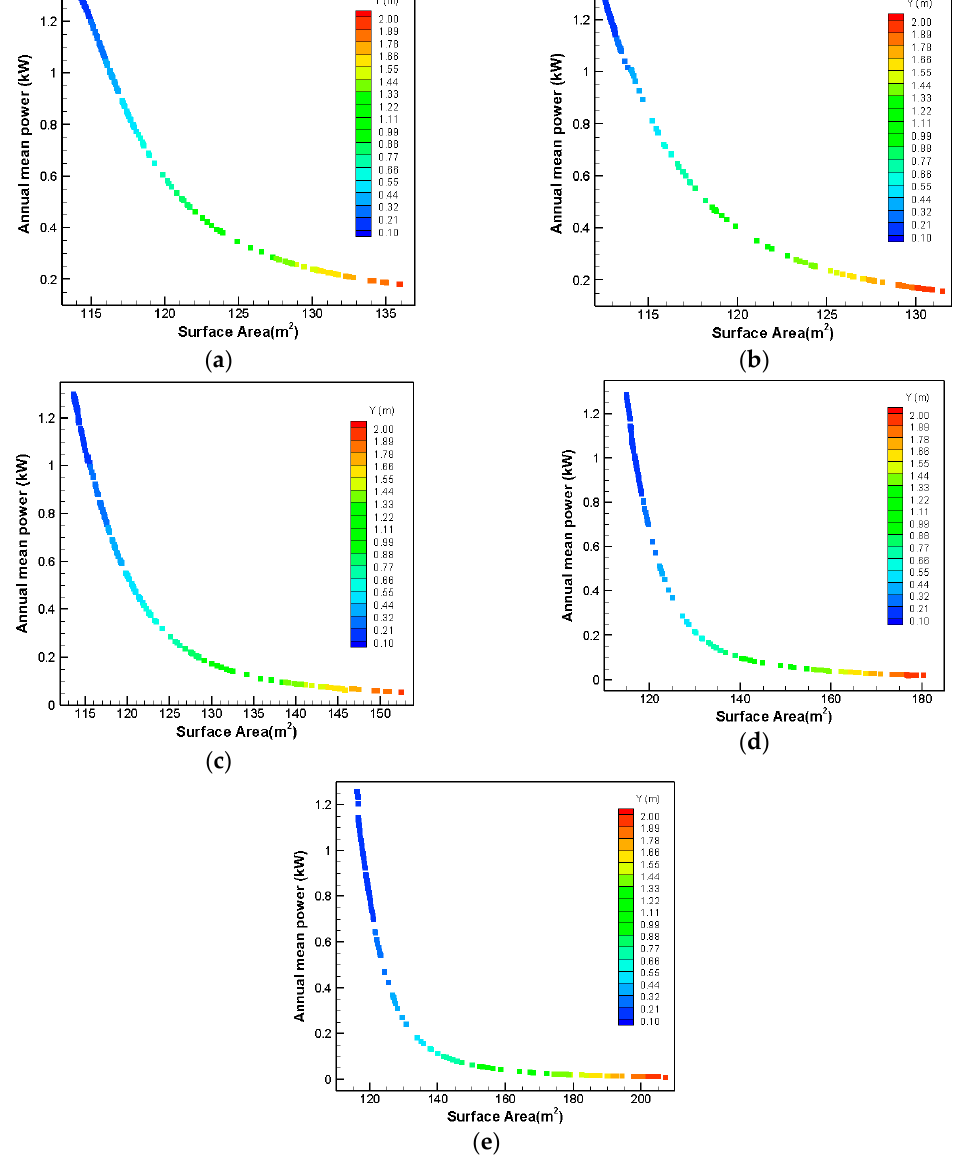
Figure 20. Optimization results for ( a ) the upside filleted shape, ( b ) the upside chamfered shape with X:Y of 1:1, ( c ) the upside chamfered shape with X:Y of 2:1, ( d ) the upside chamfered shape with X:Y of 3:1, and ( e ) the upside chamfered shape with X:Y of